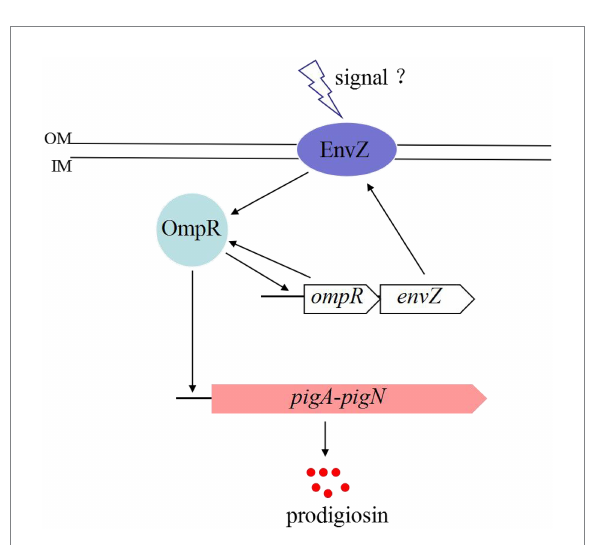
FIGURE 4 Proposed model of OmpR involvement in the regulatory mechanism of prodigiosin biosynthesis in S. marcescens FZSF02.